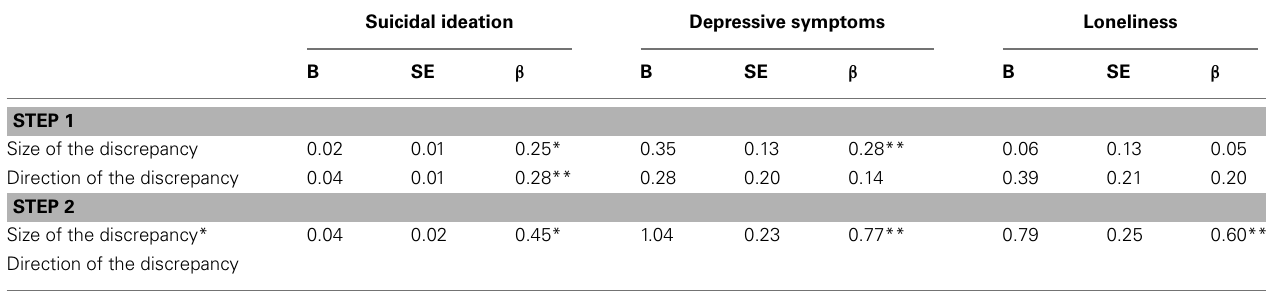
Table 4 | Hierarchical multiple regression analyses: associations of the size of the discrepancy, direction of the discrepancy, and the interaction between the size of the discrepancy and the direction of the discrepancy with suicidal ideation, depressive symptoms, and